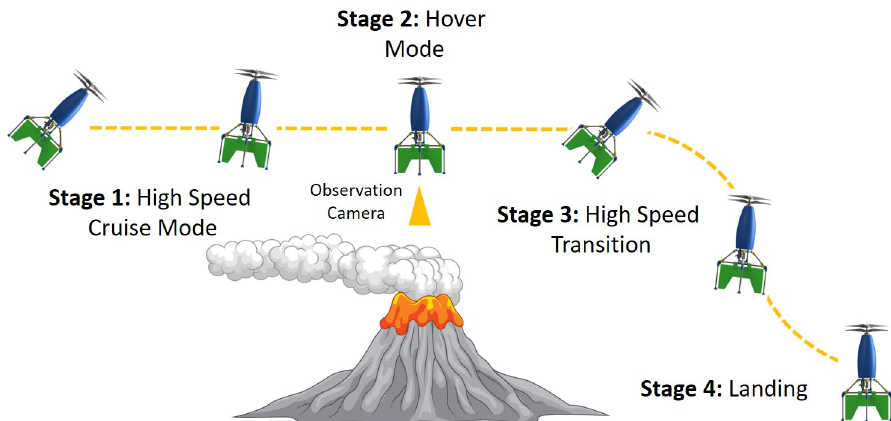
Figure 1. MCR UAV v3.0 main